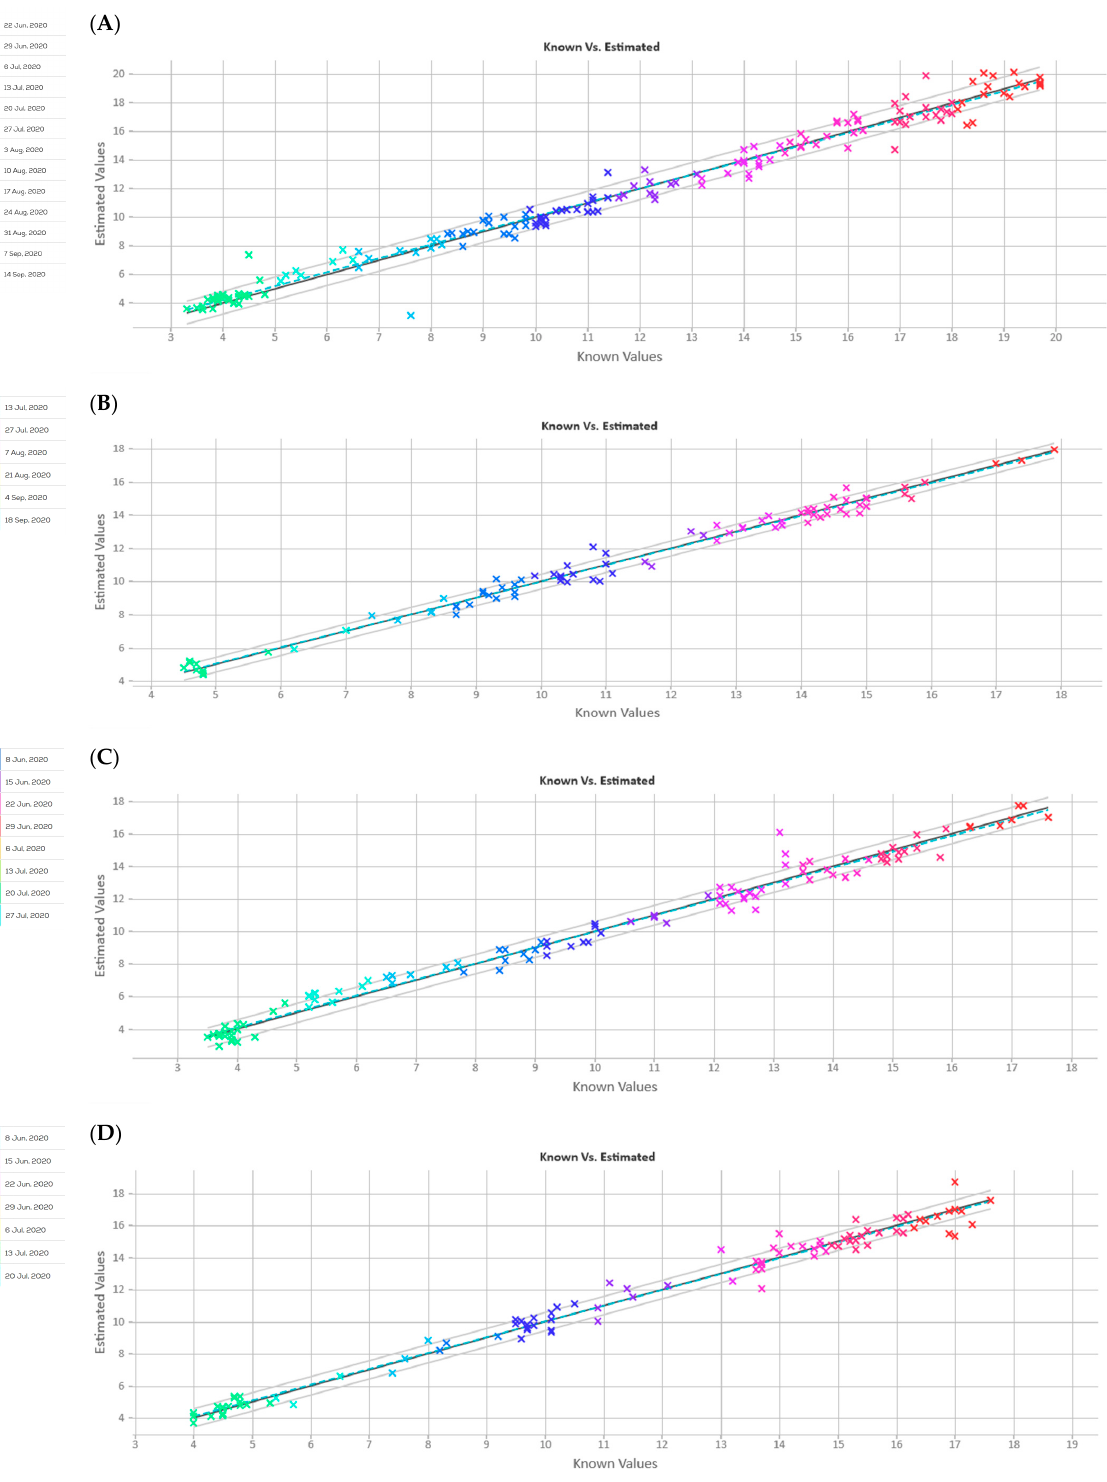
Figure 5. Measured versus predicted TSS values in the calibration set and prediction set for Allison™ ( A ), Autumncrisp ® ( B ), Cotton Candy™ ( C ) and Summer Royal ( D ). The different colors indicate the various sampling times for each cultivar as shown in the